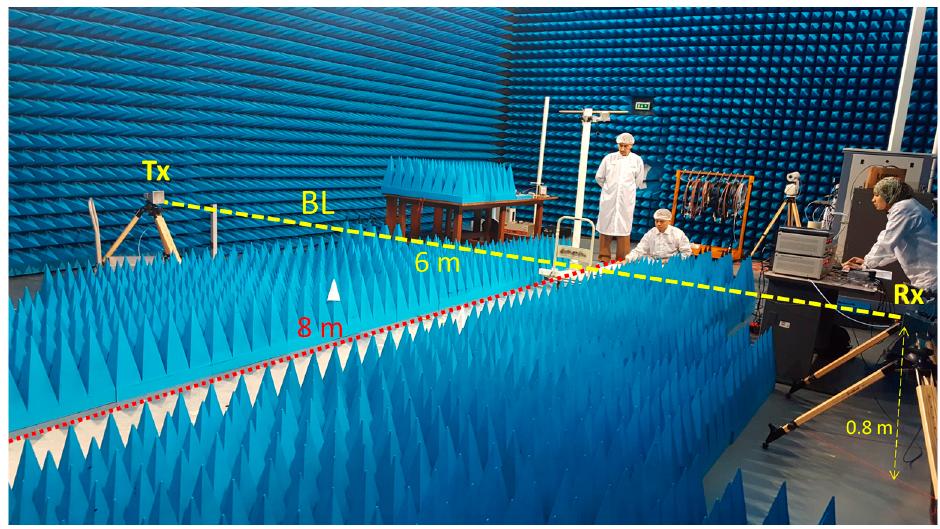
Figure 10. FSR experiment configuration inside the anechoic chamber.